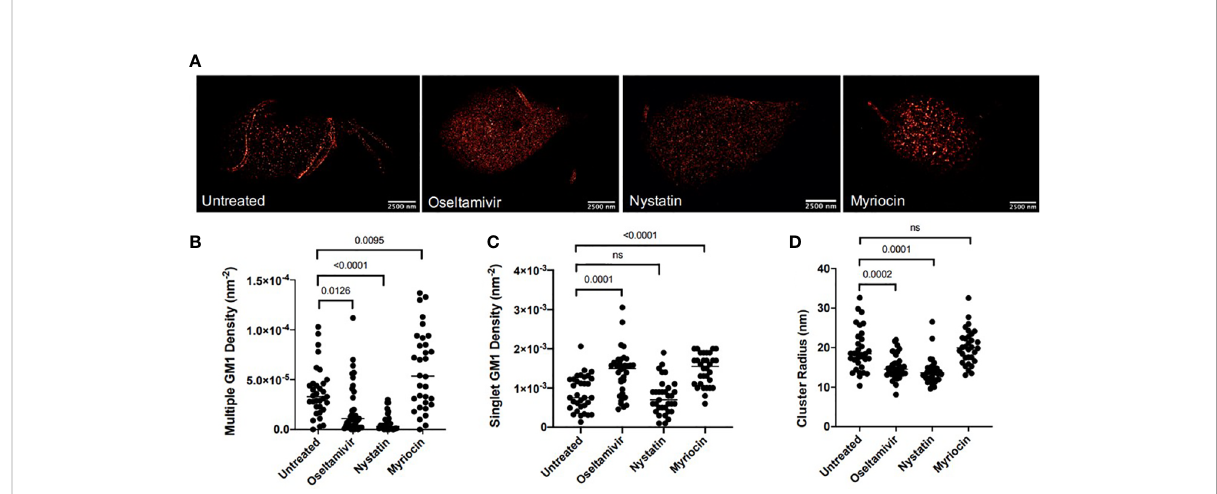
FIGURE 2 Nanoscopic GM1 clustering characteristics. (A) Representative dSTORM images of G lamblia untreated and treated with various agents. Bars, 2500nm (B) Hierarchical clustering quanti fi cation of nanoscopic GM1 cluster geometries for densities of multiple GM1 clusters. (C) Hierarchical clustering quanti fi cation of nanoscopic GM1 singlet densities. (D) Quanti fi cation of GM1 cluster radii. 15 cells were imaged per sample, and regions of interest (ROI) were selected on each cell. Each sample ranges from 32-35 total ROIs investigated. ns, non signi fi